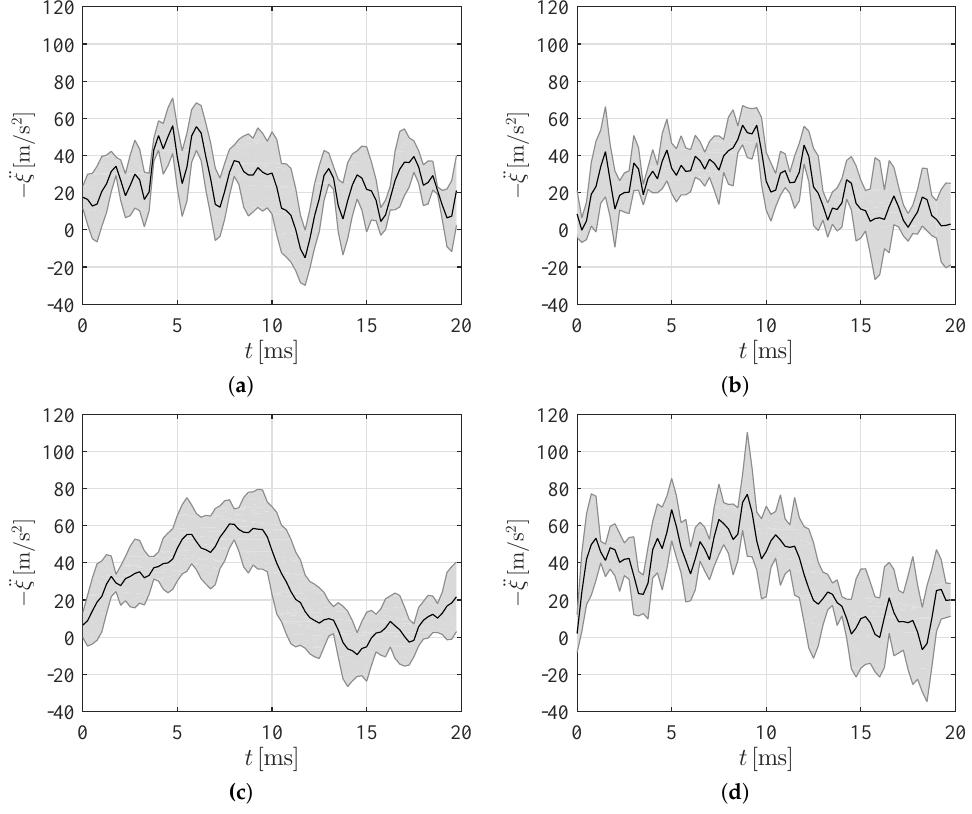
Figure 6. Time trace of the mean acceleration of the keel for ( a ) Light-Short; ( b ) Heavy-Short; ( c ) Light-High; and ( d ) Heavy-High conditions. The shaded area represents one standard deviation across